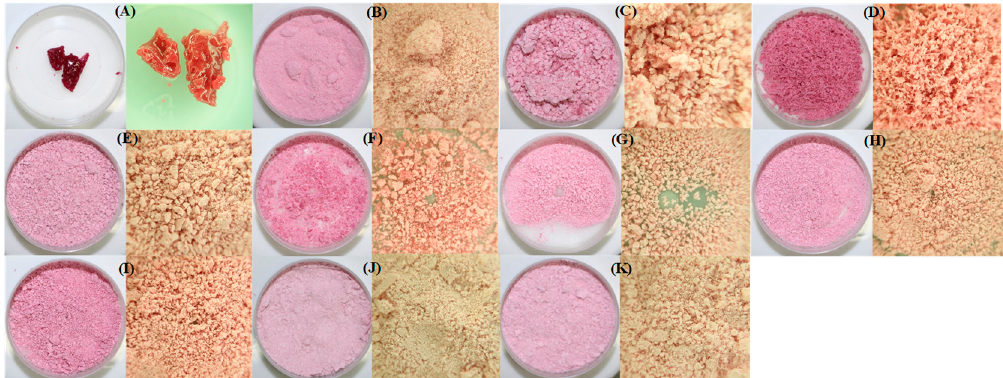
Figure 1. Optical micrographs of Blueberry juice-Maltodextrin (BJ-MX) samples after the spray drying process. Couples of images were arranged as low magnification in the left and high magnification in the right. The cylindrical container has a diameter of 4 cm, while the length of the high magnification image is 1 cm. Run identification ( A ) 9, ( B ) 3, ( C ) 5, ( D ) 6, ( E ), 12, ( F ) 15, ( G ) 16, ( H ) 21, ( I ) 22, ( J ) 24, and ( K ) 25.